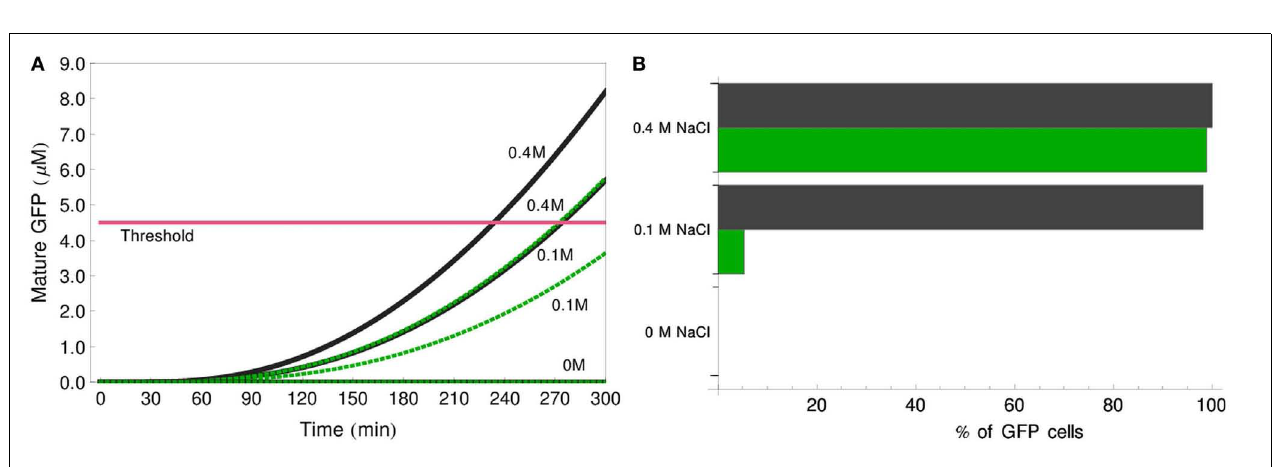
GFP threshold. (B) Results of stochastic simulation showing percentage of reporter cells of each type that score fluorescence-positive after stimulation with 0, 0.1, or 0.4M NaCl. Black bars – reporter cells with wild-type Ste2, green bars – reporters carrying Ste2 F262A